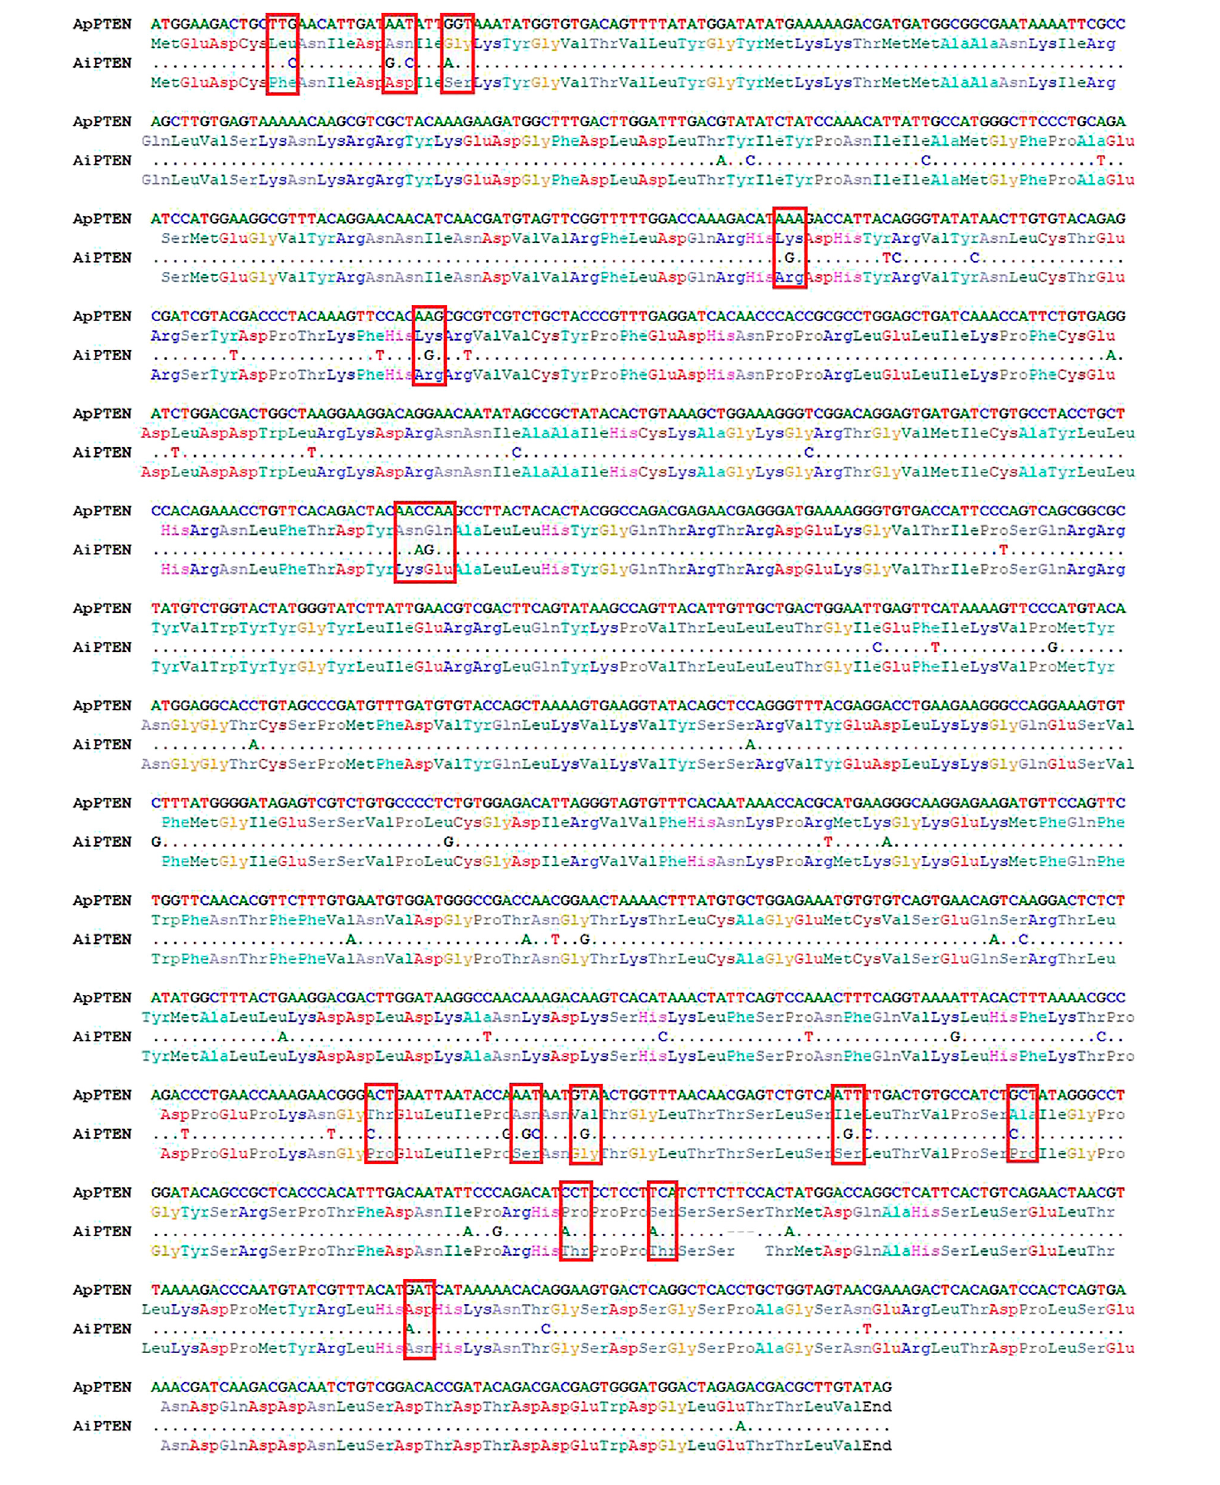
Frontiers in Physiology |